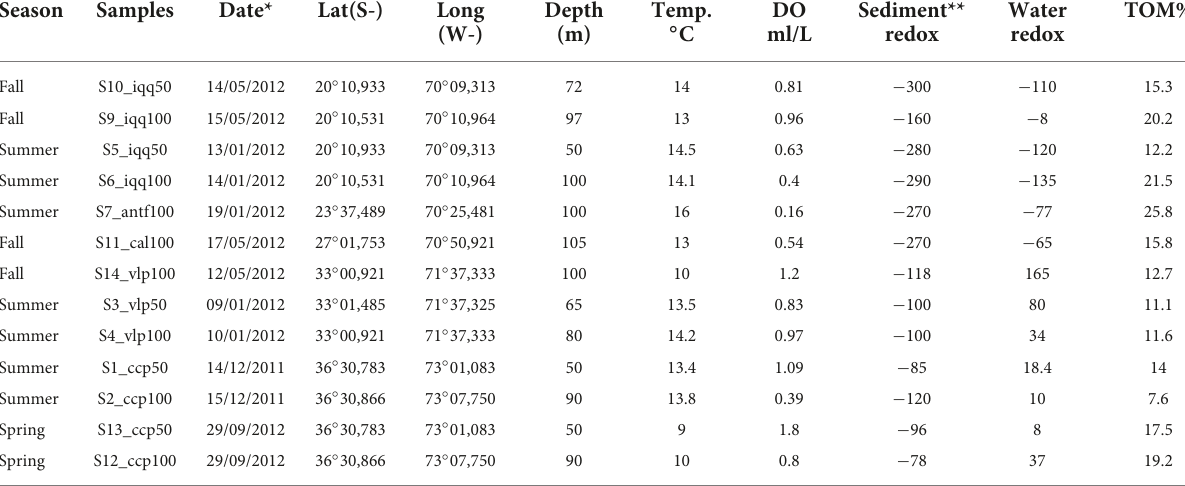
TABLE 1 Metadata for the sampling points included in the study.